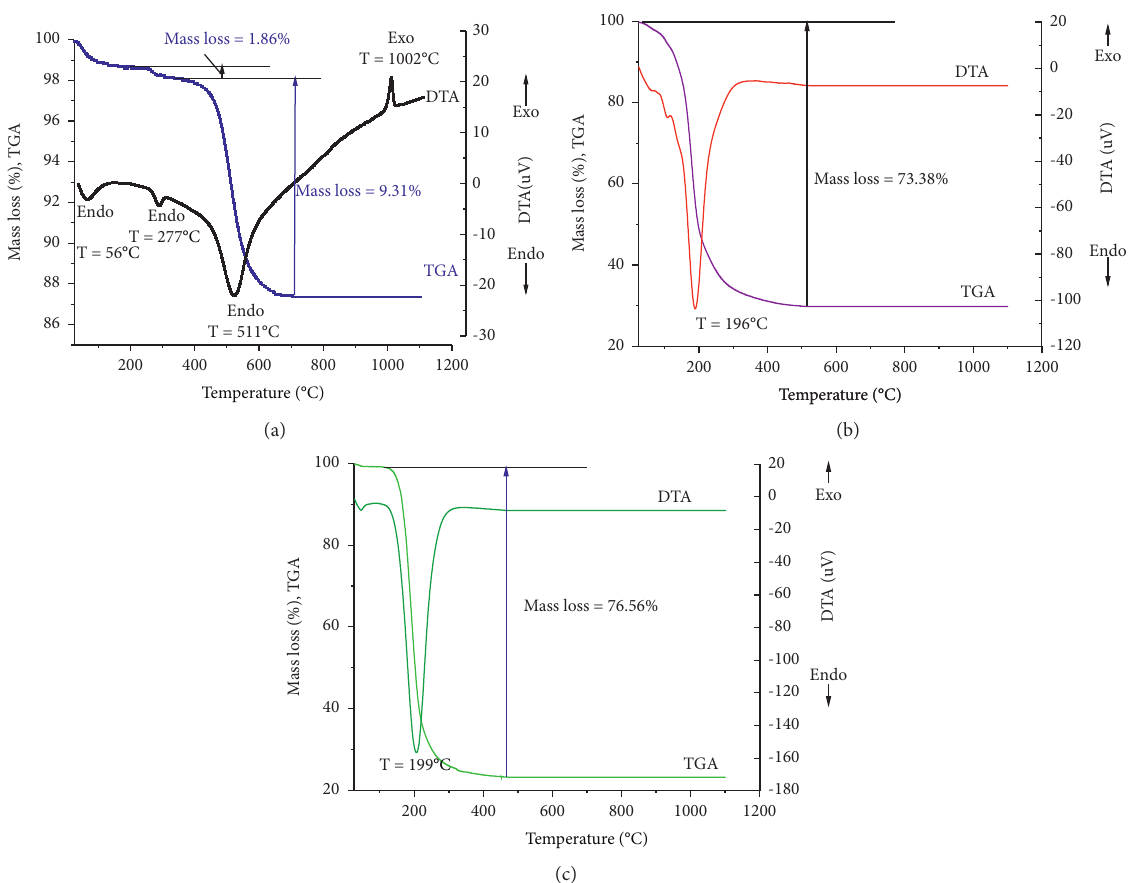
Figure 4: TGA curves of (a) kaolinite, (b) extracted aluminum at 700 ° C, 180min, and 106 μ m, and (c) standard aluminum chloride